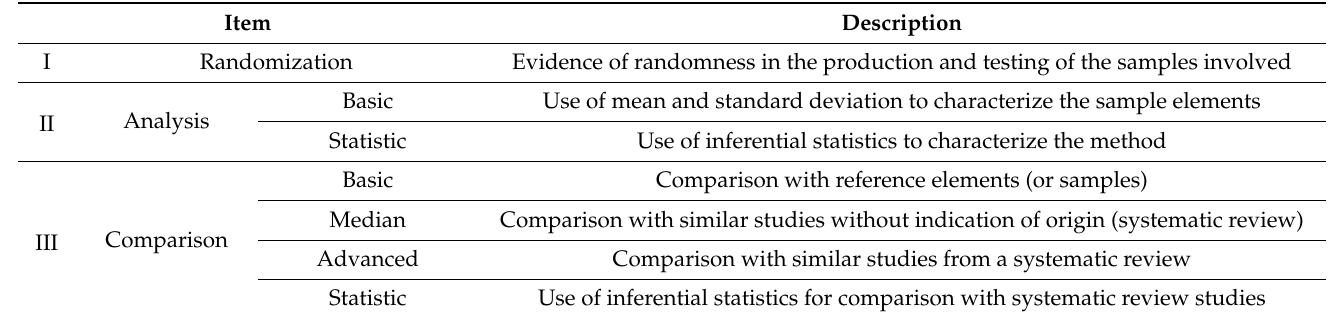
Table 3. Items for the methodology quality analysis of a paper according to the SREE method.